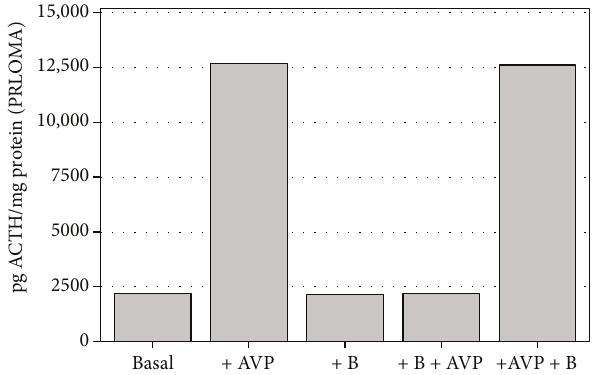
Figure 2: Functional assay for ACTH release in rat prolactinoma cultures (PRLOMA), in vitro ( n = 11 − 12 in each group); mean level ± SEM (pg ACTH/mg protein): compared with normal AdH cells (Figure 1). ACTH release always shows a similarly signi fi cant ( p < 0 001 ) increase in PRLOMA cells (basal: control; AVP: 8- arginine vasopressin; B: